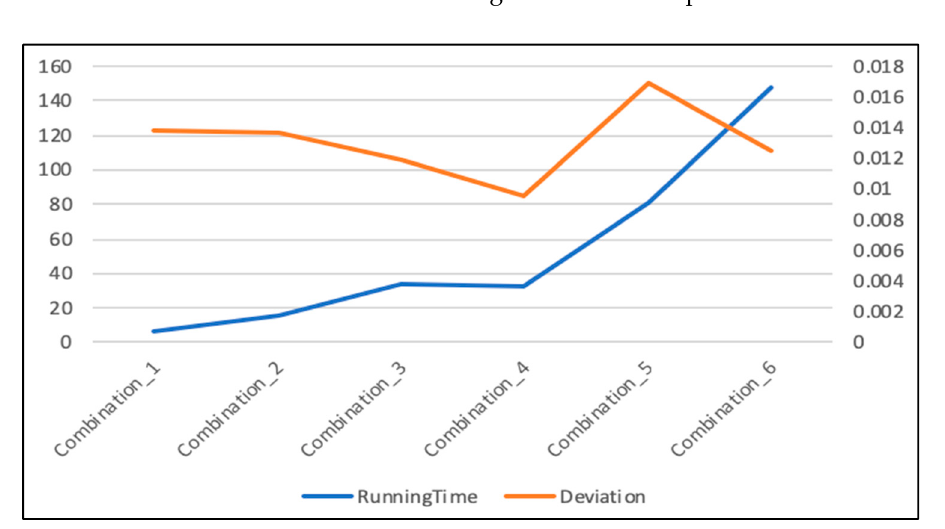
Figure 8. Results of different situations.